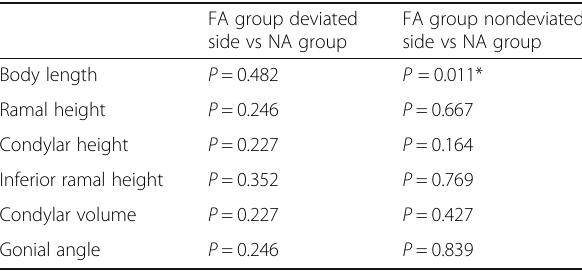
Table 4 Comparison of the mandibular components of each side in the FA group and of those in the NA group FA group deviated FA group nondeviated side vs NA group side vs NA group Body length P = 0.482 P = 0.011* Ramal height P = 0.246 P = 0.667 Condylar height P = 0.227 P = 0.164 Inferior ramal height P = 0.352 P = 0.769 Condylar volume P = 0.227 P = 0.427 Gonial angle P =